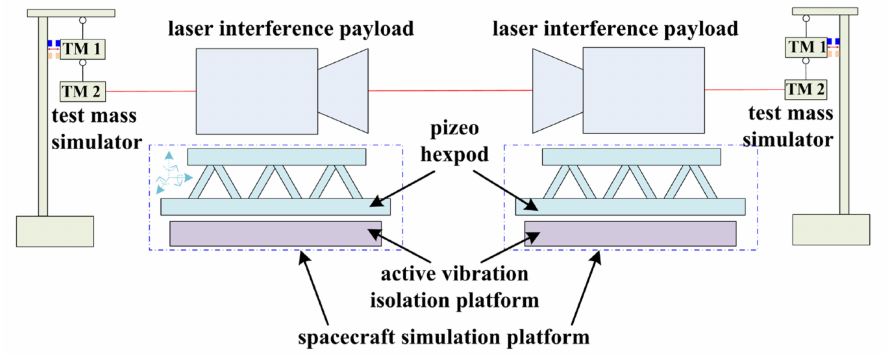
Figure 10. Technical solution for the semi-physical simulation test for the interferometry of inter- satellite